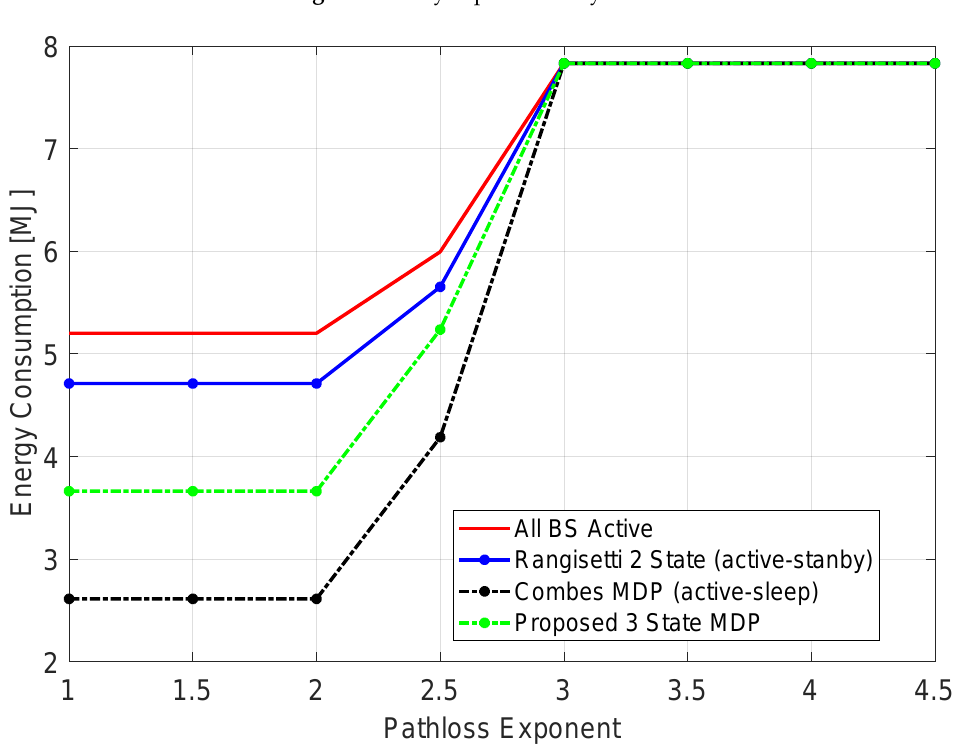
Figure 10. Effect of varying pathloss